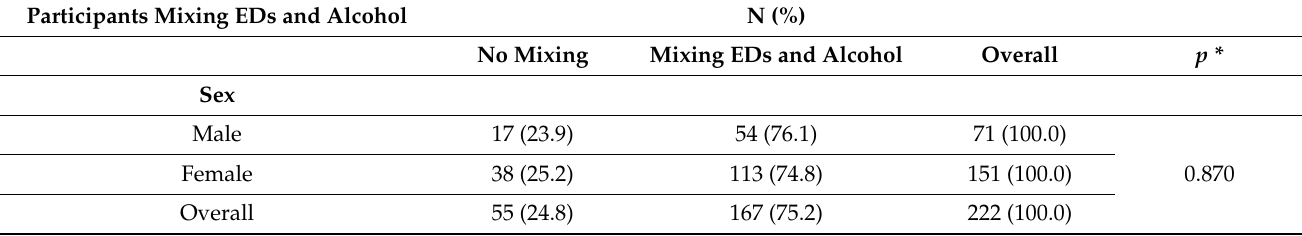
Table 5. The amount of EDs consumed in combination with alcohol according to